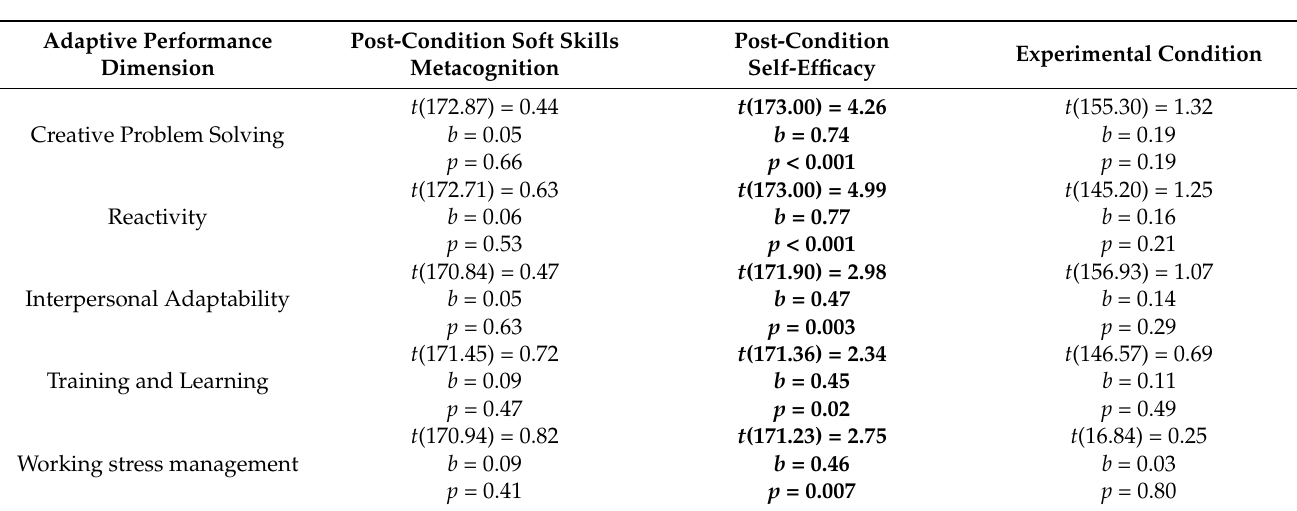
Table 5. Outputs of models predicting post-condition adaptive performance sub-scores based on pre-condition adaptive performance, pre- and post-condition soft skills metacognition, pre- and post-condition self-efficacy and experimental